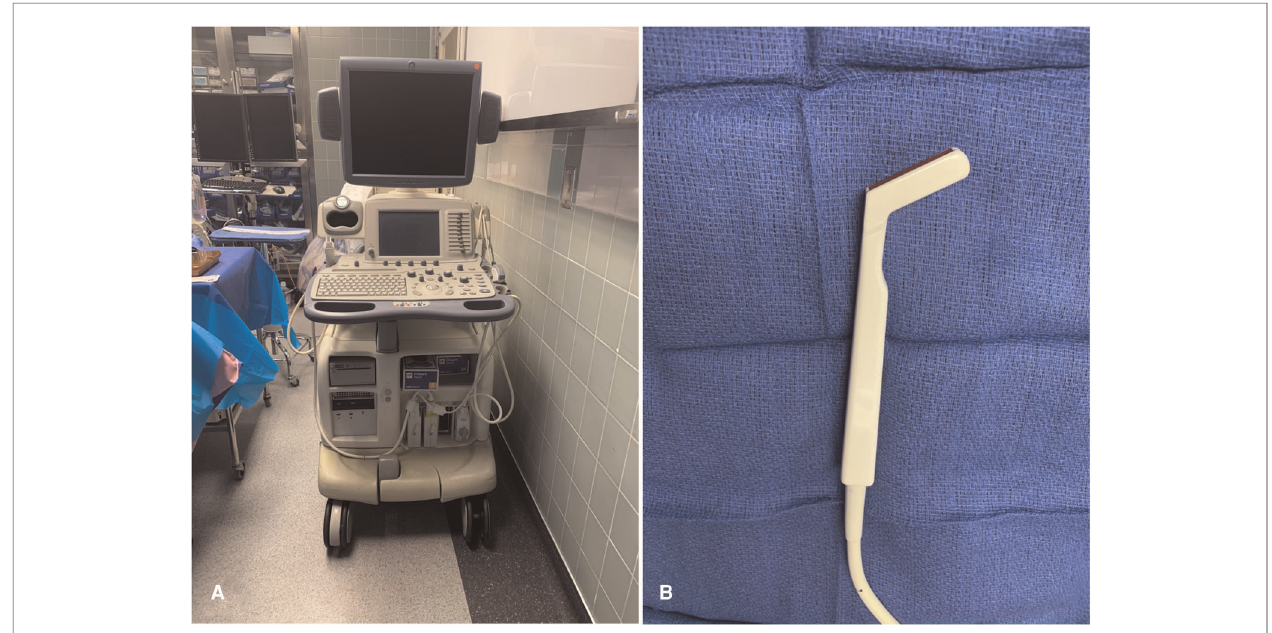
FIGURE 1 | ( A ) Intra-operative GE ultrasound used for measuring sigmoid sinus velocities. ( B ) The hockey stick probe used for measuring sigmoid sinus